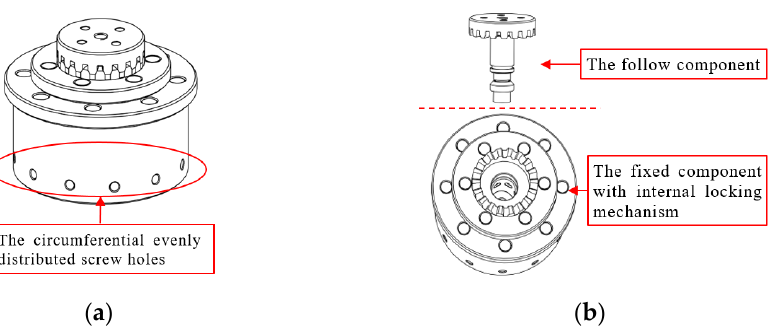
Figure 1. Schematic diagram of two working states of the designed fixture. ( a ) Locking state; ( b ) unlocking separation status.